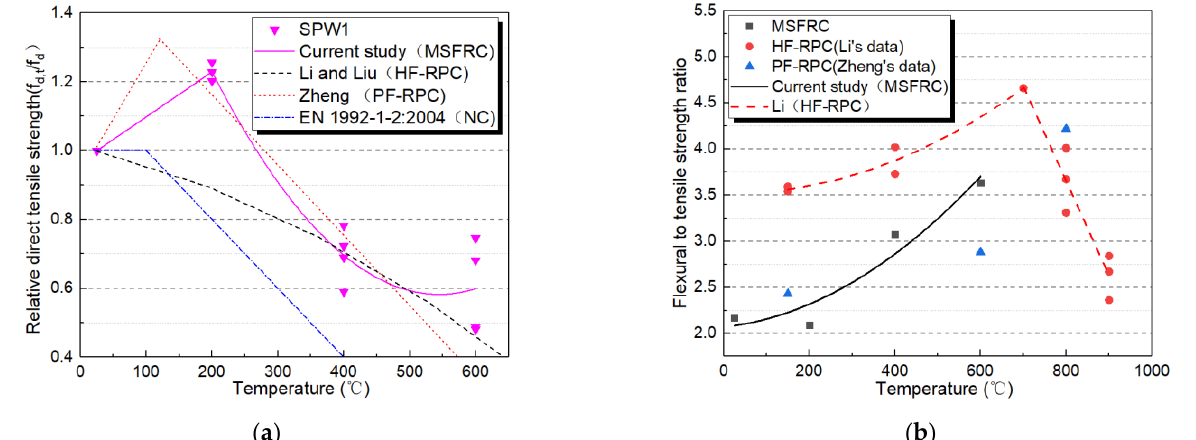
Figure 8. Computation model of uniaxial tensile strength of heated MSFRC ( a ) Relative uniaxial tensile strength versus temperature; ( b ) Flexural to uniaxial tensile strength ratio versus temperature.